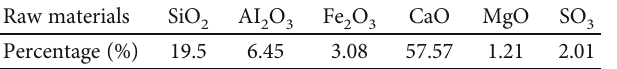
Table 1: Cement chemical composition table. Raw materials SiO